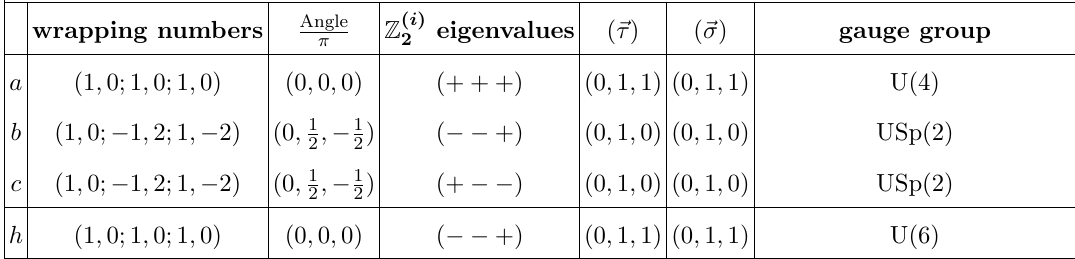
Table 21 . Pati-Salam model, prototype I, on the T 6 = ( Z 2 (cid:2) Z 6 (cid:2) (cid:10) R ) orientifold with discrete torsion. The three-cycles wrapped by the D6-branes a and b are identical to those of the MSSM example in table